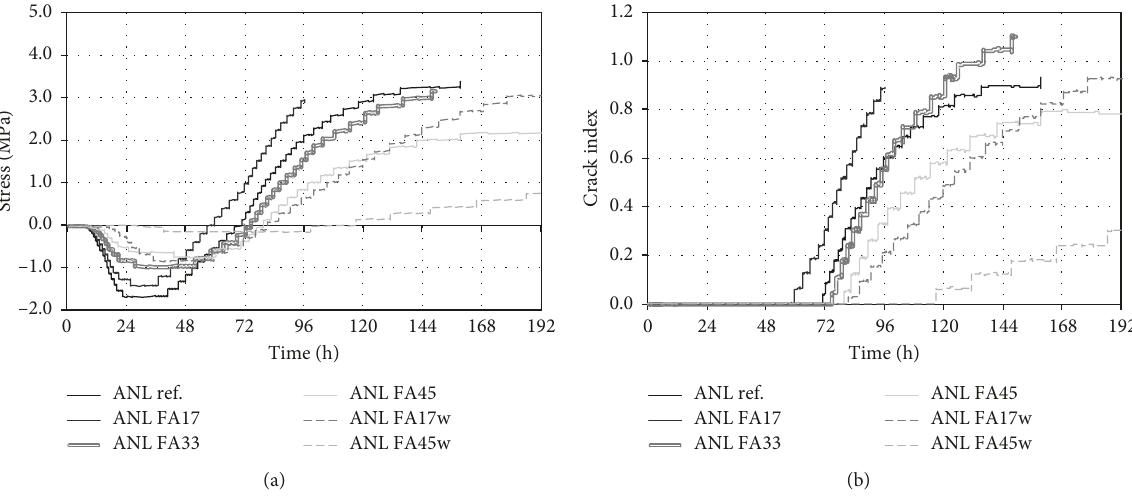
Figure 8: Measured stress development in the TSTM (a) and deduced crack index